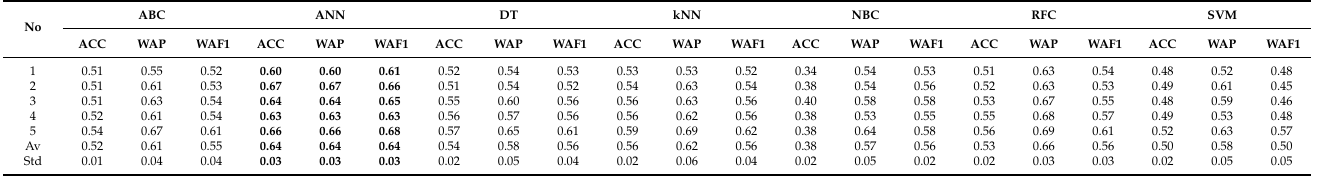
Table 9. Cross validation test results for the text